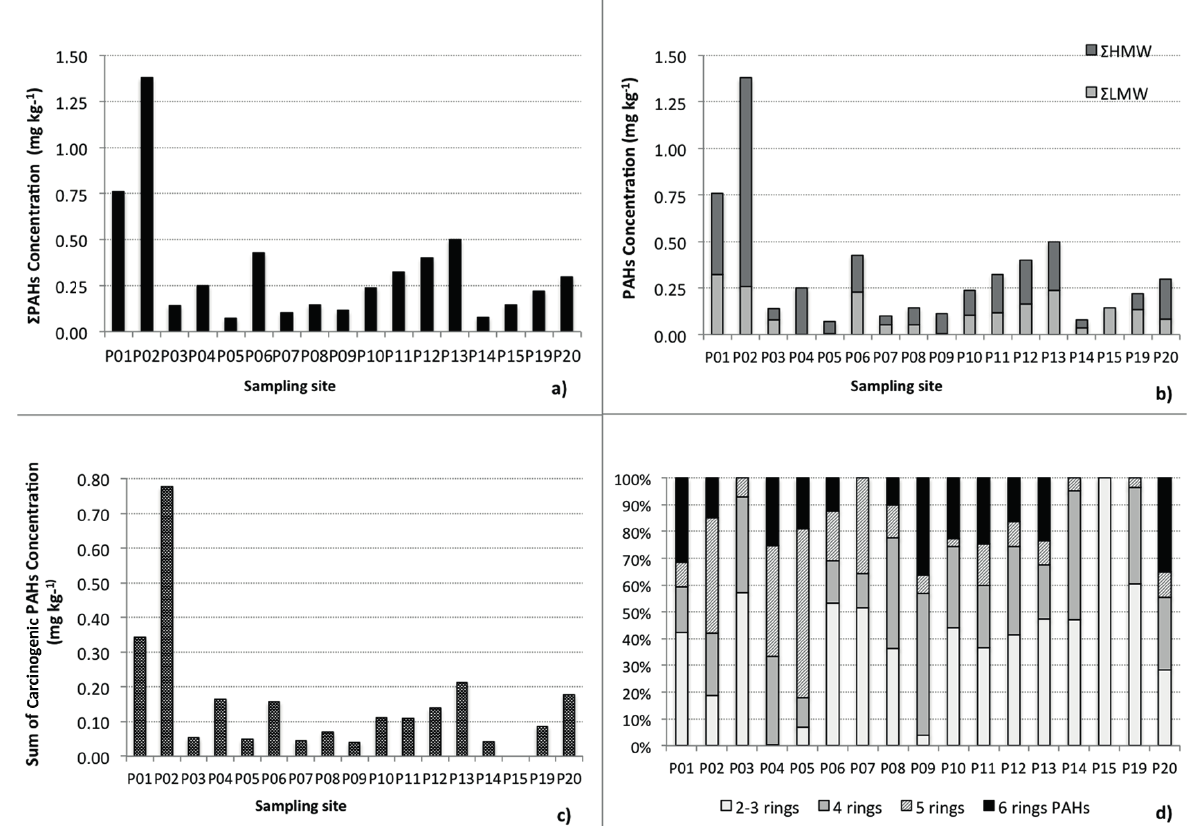
Figure 3 - Variation of (a) ∑PAHs concentrations (mg kg -1 ), (b) sum of low (LMW) and heavy molecular weight (HMW) PAHs concentrations (mg kg -1 ), (c) ∑carcinogenic PAHs (BaA, CHRY, BbF, BkF, BaP, DBahA, IND) concentrations (mg kg -1 ), and (d) aromatic ring numbers percentage distribution between sampling